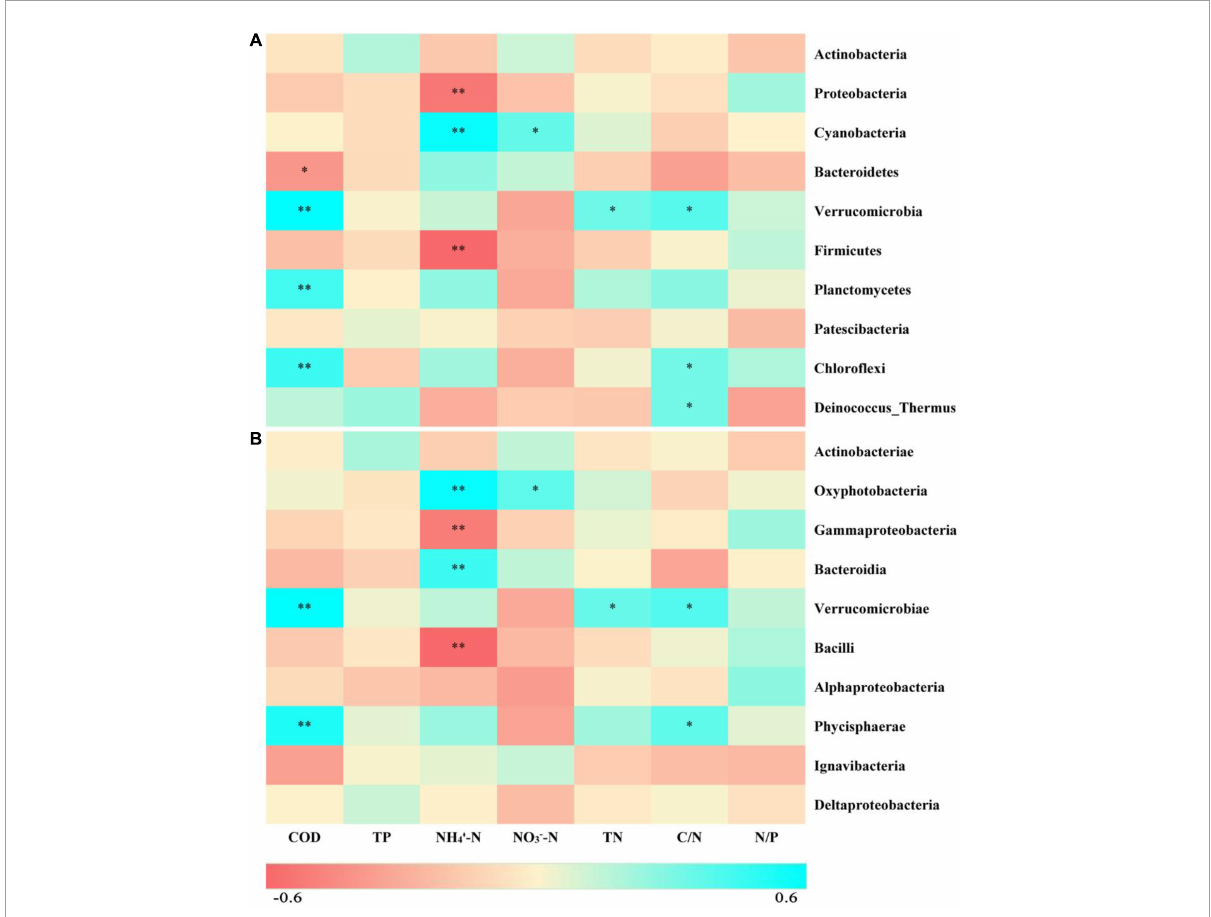
FIGURE6 Heatmap depicting correlations between physicochemical properties of the freshwater and the 10 most abundant bacteria at the (A) phylum and (B) class levels. Red indicates negative correlations, while cyan indicates positive correlations. ** represents p < 0.01, and * represents p <